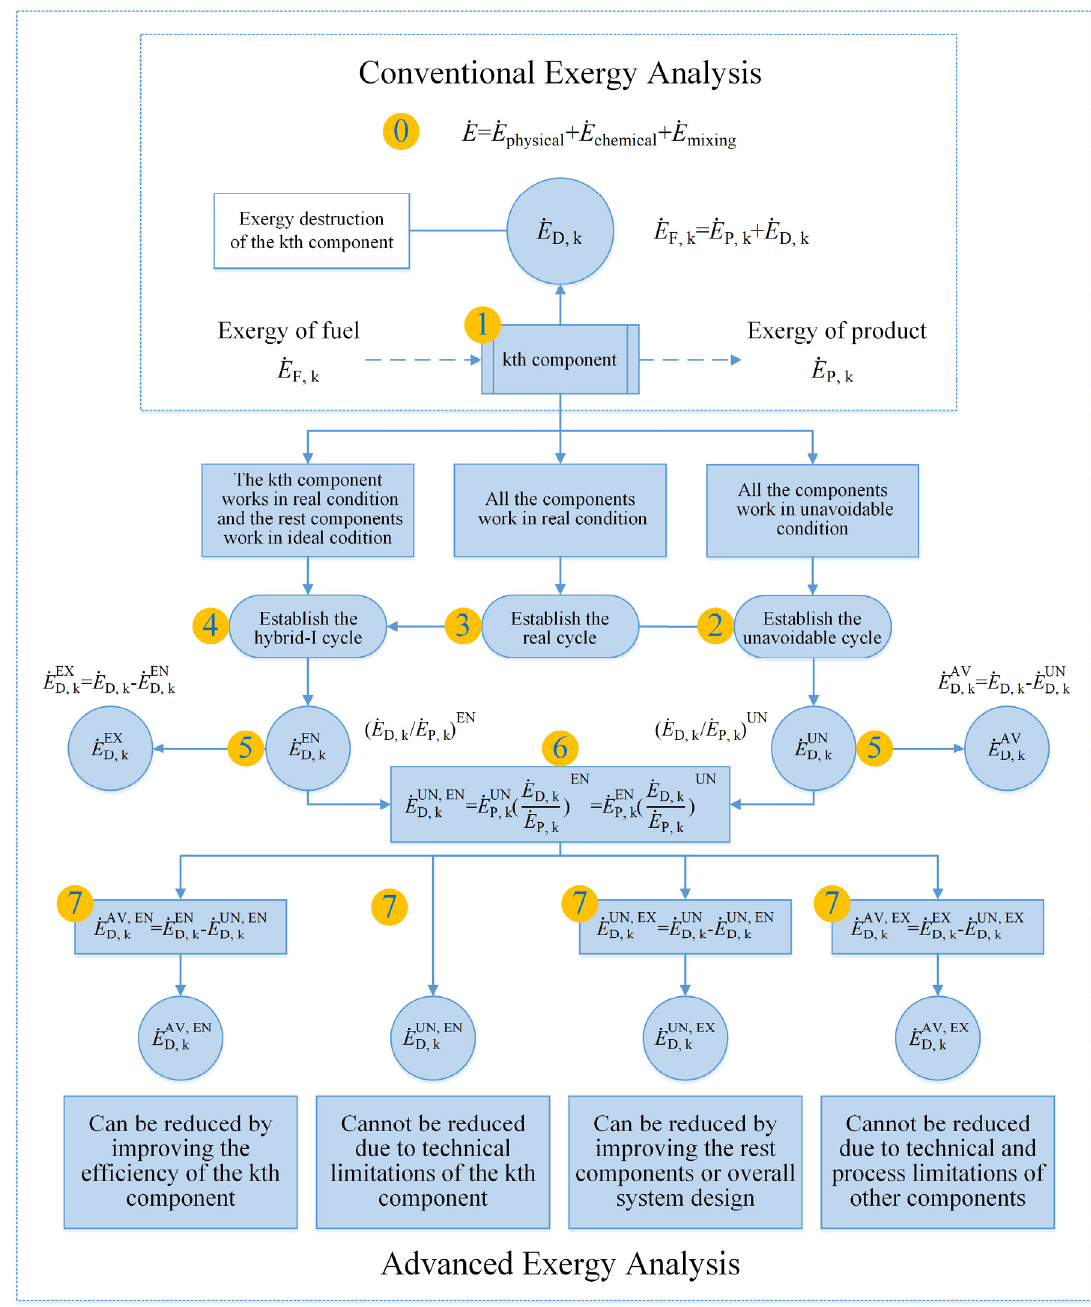
Figure 3. Flowchart for exergy destruction